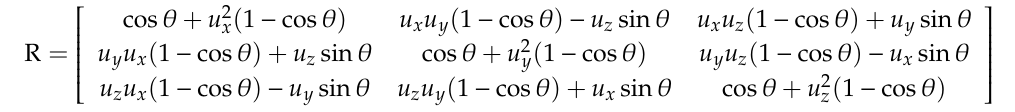
→ y ) and bridge coordinate system (